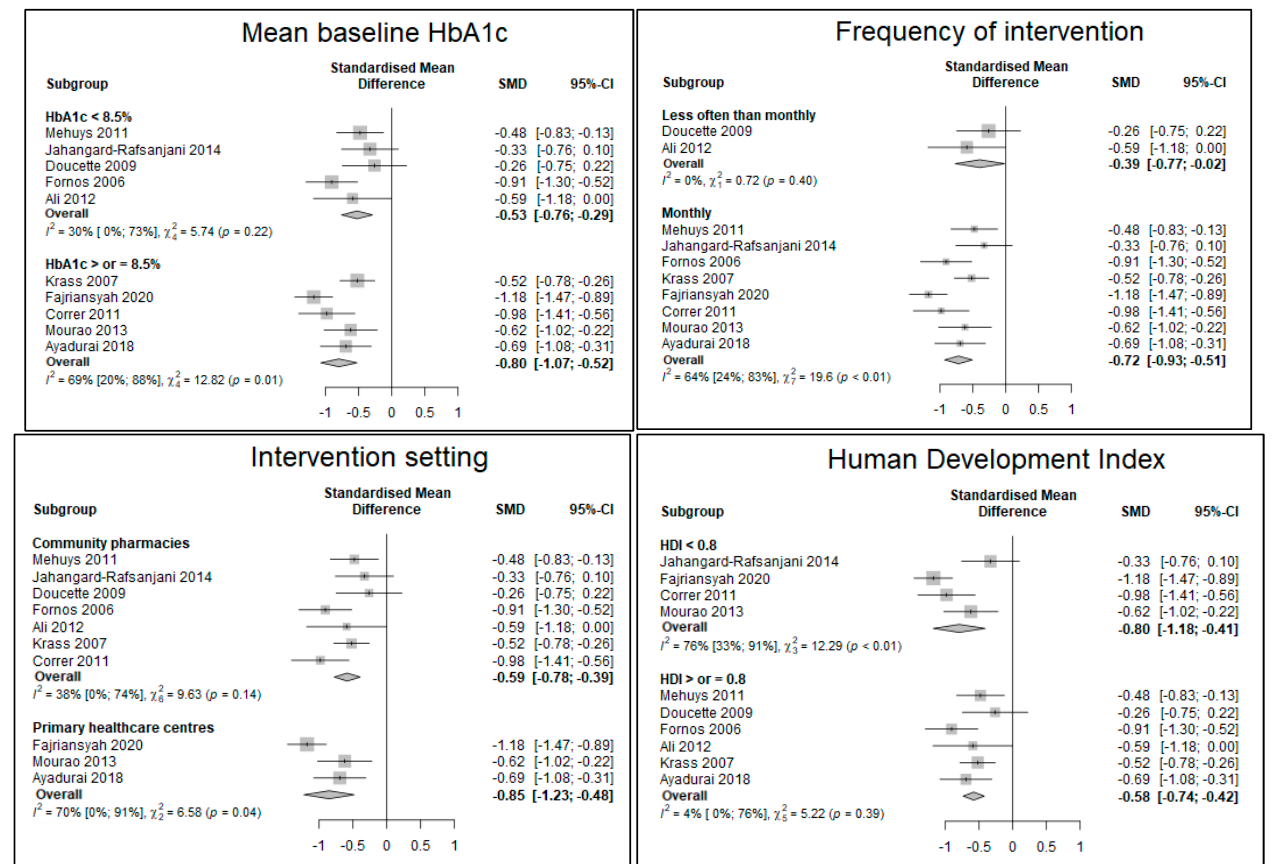
Figure 3. Forest plot of the subgroups analyses of the mean difference in HbA1c levels in the inter- vention group compared with the usual pharmaceutical care group using random effects model.